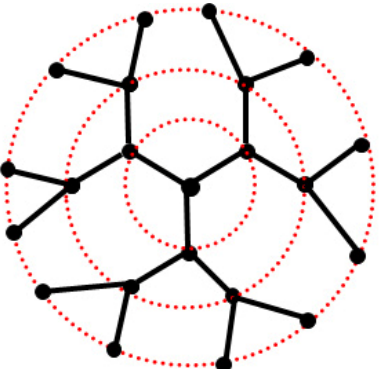
Figure 1. A schematic drawing of the topology of a dendrimer. In this coarse-grained model, there is a single tri-functional core ( f = 3), binary dendra ( m = 2) and a single bond connecting adjacent branch points ( p = 1), while the dotted circles indicate the successive generations g . This is a second-generation dendrimer ( g = 2) if g is numbered from 0 onward, but in some cases, if the numeration starts from 1, it will be denoted as a third-generation dendrimer.